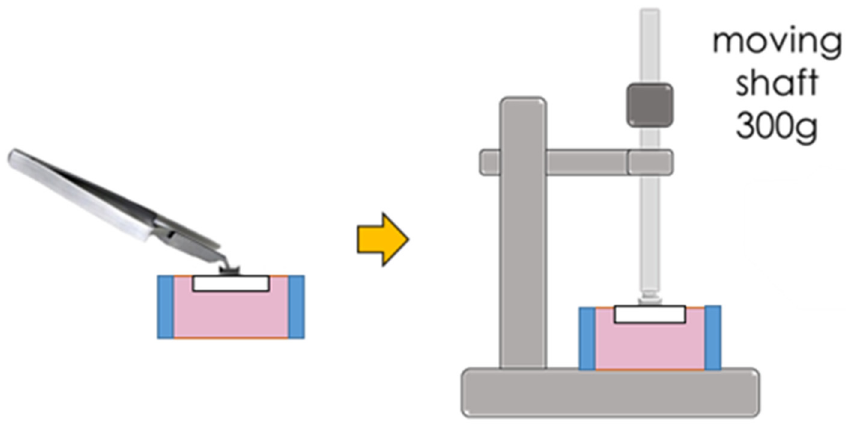
Figure 3. Precoated brackets were placed using moving shaft of 300 g after sample surface preparation.